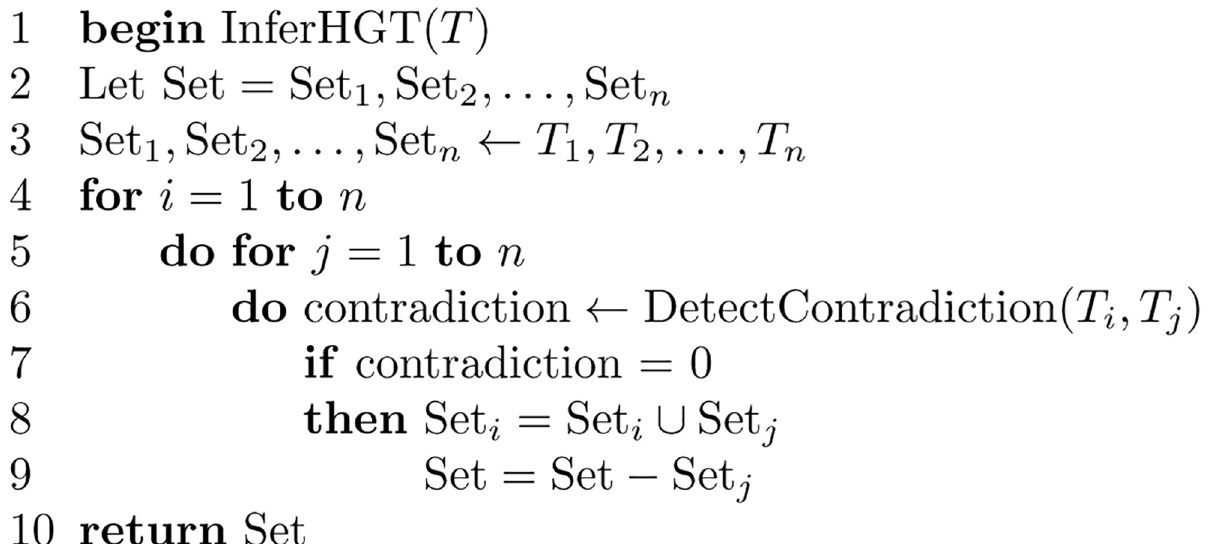
Fig 33. Algorithm to infer HGT.